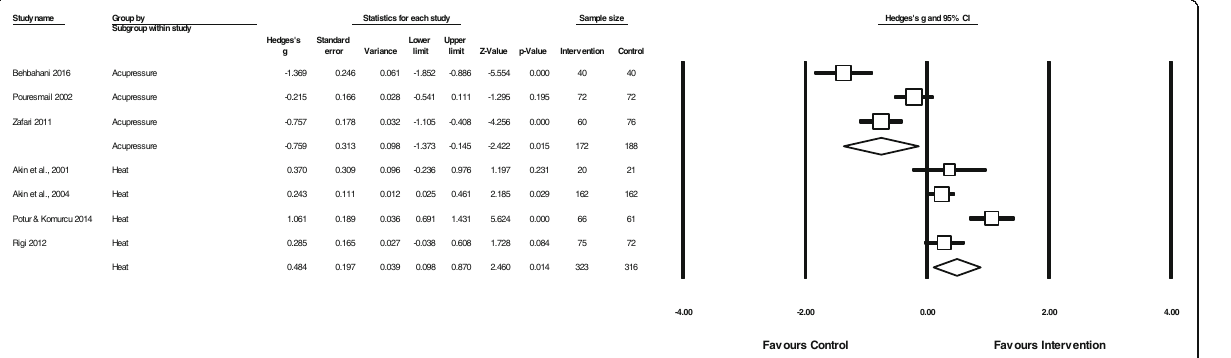
Fig. 5 Comparison of the effect of acupressure or heat versus analgesic medication on menstrual pain